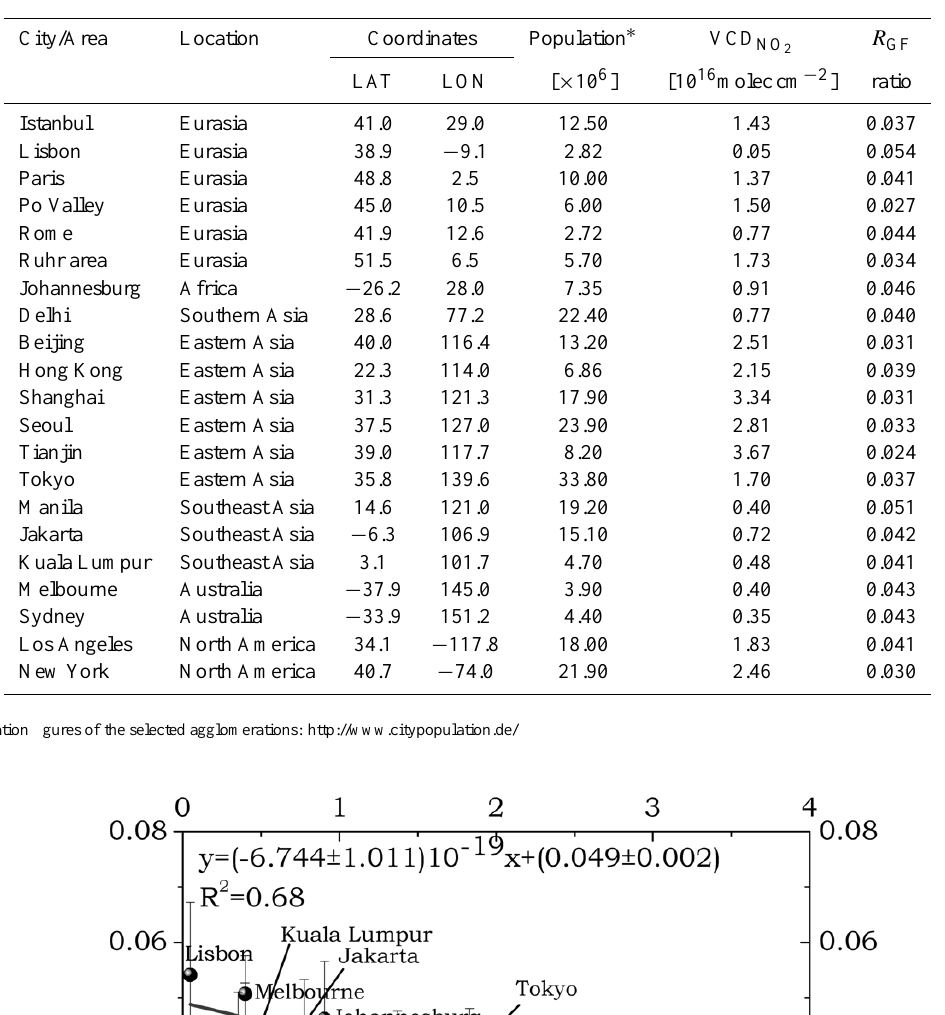
Table 3. Computed vertical column densities of NO 2 and R GF ratio for a selection of cities/areas along with their corresponding latitude (N > 0, S < 0), longitude (E > 0, W < 0) and population records. The VCD NO surrounding a central point denoted by the given coordinates.